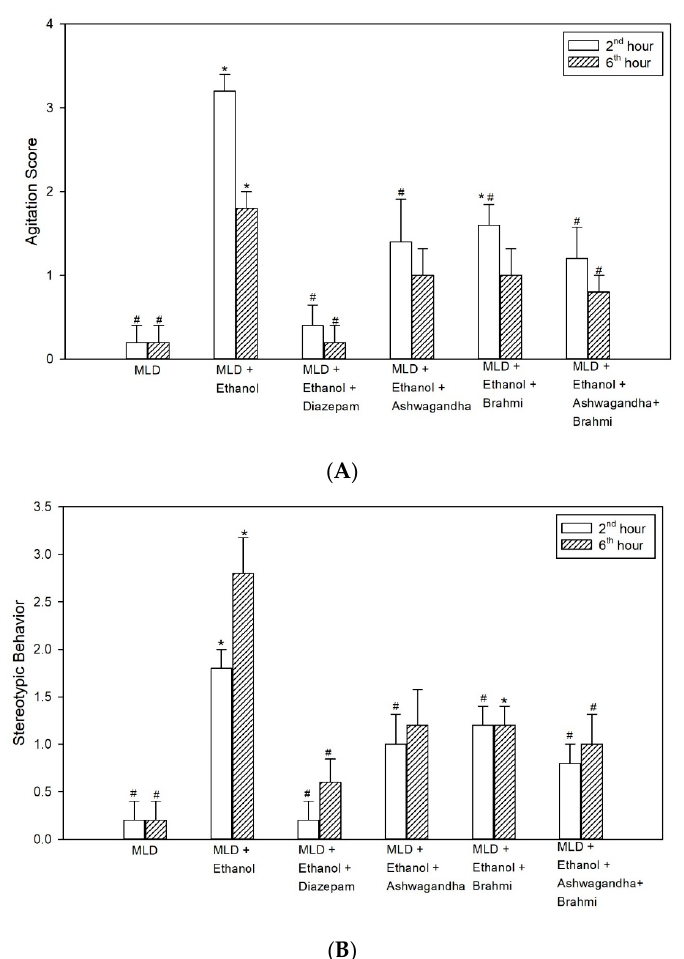
Figure 3. Effect of test drugs on behavioural changes ( A ) Agitation ( B ) Stereotypic behaviour at 2nd hour and 6th hour of alcohol withdrawal in rats. (‘*’ represents statistically significant compared with MLD group. ‘#’ represents statistically significance compared with MLD + Ethanol group.).